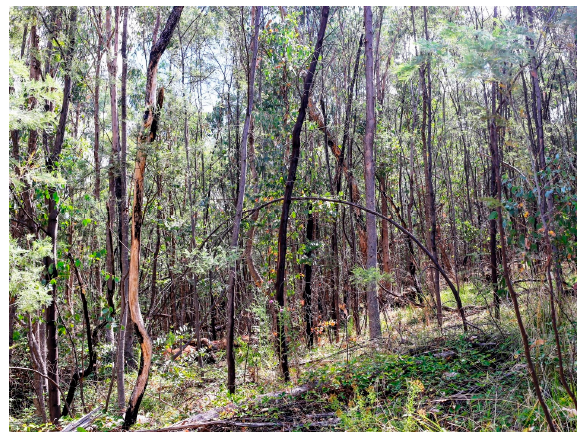
Figure 9. Open forest two years after moderate severity fire.